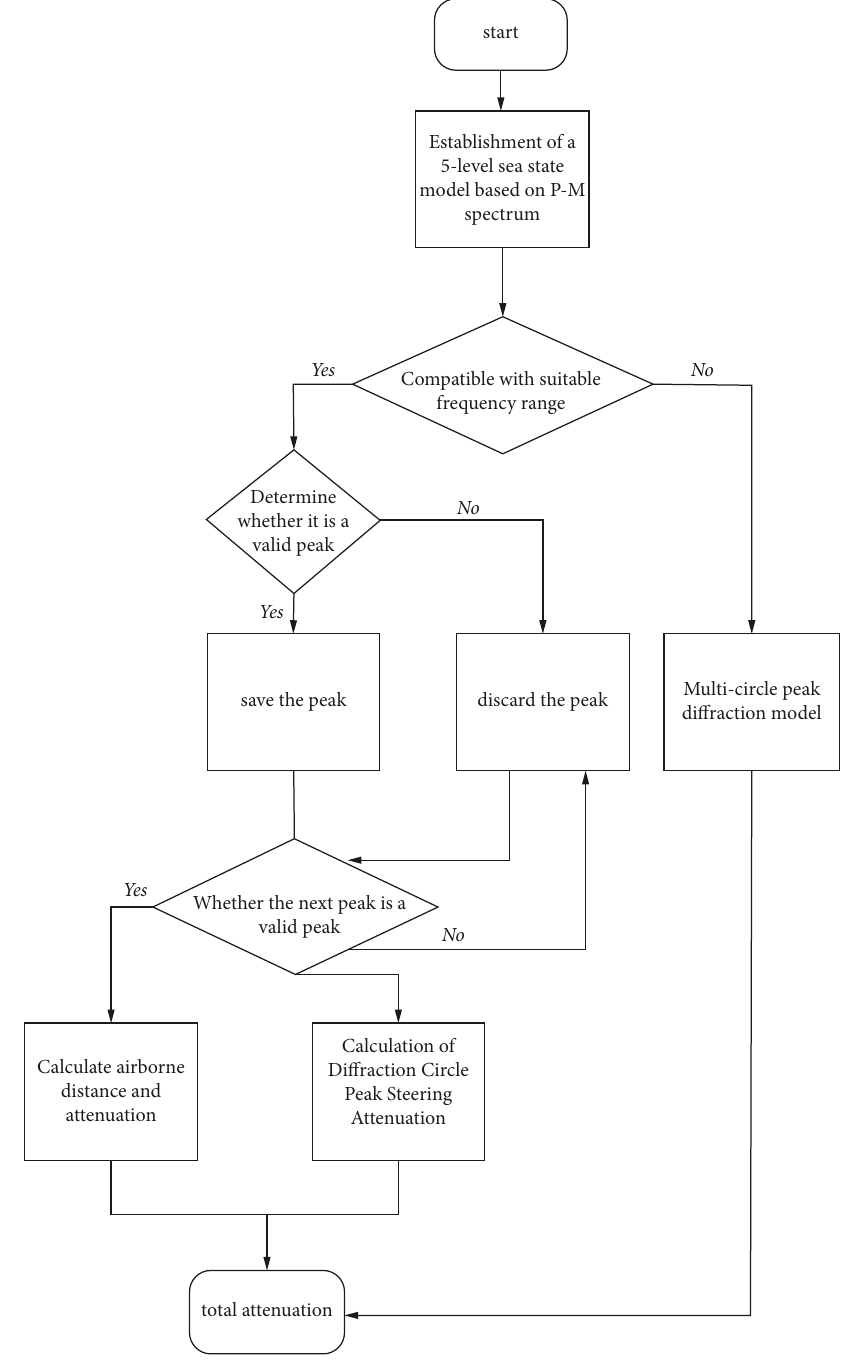
Figure 13: Program diagram of link-peak diffraction